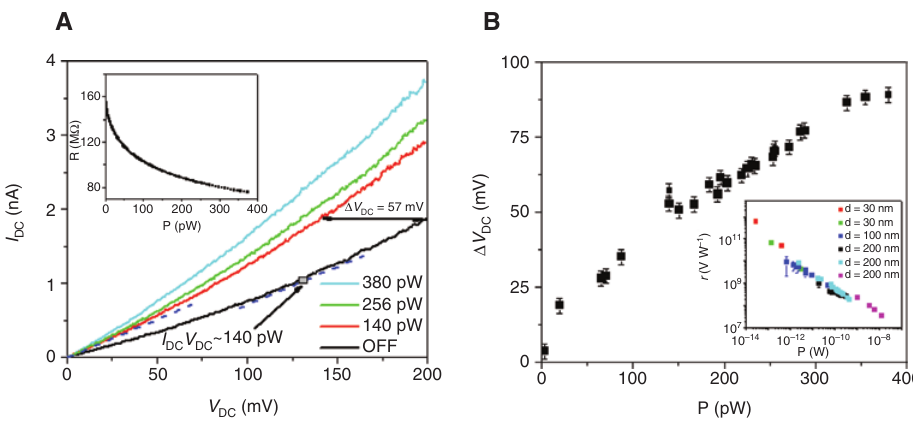
Figure 2: Measurements of photovoltage and absorbed power from IV curves. (A) IV characteristic of a 200 nm dot without radiation (black) and with 2-mm-wavelength radiation (colors) at different values of absorbed power. Dashed lines indicate points in the curves with the same differential resistance. Inset: differential resistance of the curve with radiation OFF at different values of Joule power. (B) Photovoltage measured from the device in (A) at I power under illumination with a 2-mm-wavelength source (black squares). Inset: responsivity vs. absorbed power for the same device (black squares) and five other devices. The legend indicates the diameter of the quantum dot for each